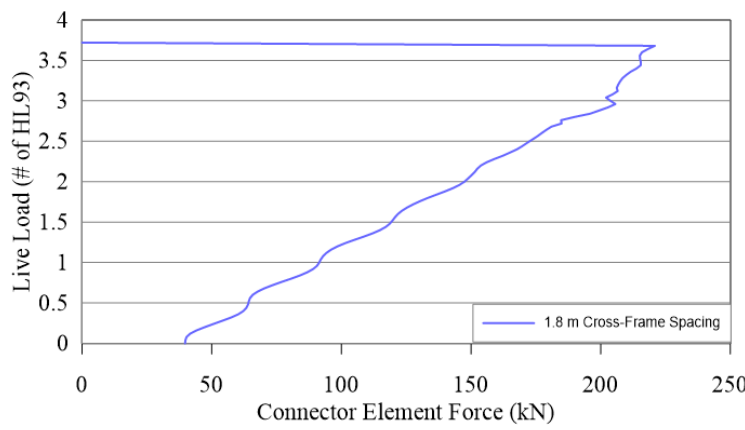
Figure 7. The connector element axial force over the loading. Table 3. Live load distribution under HL93 loading.